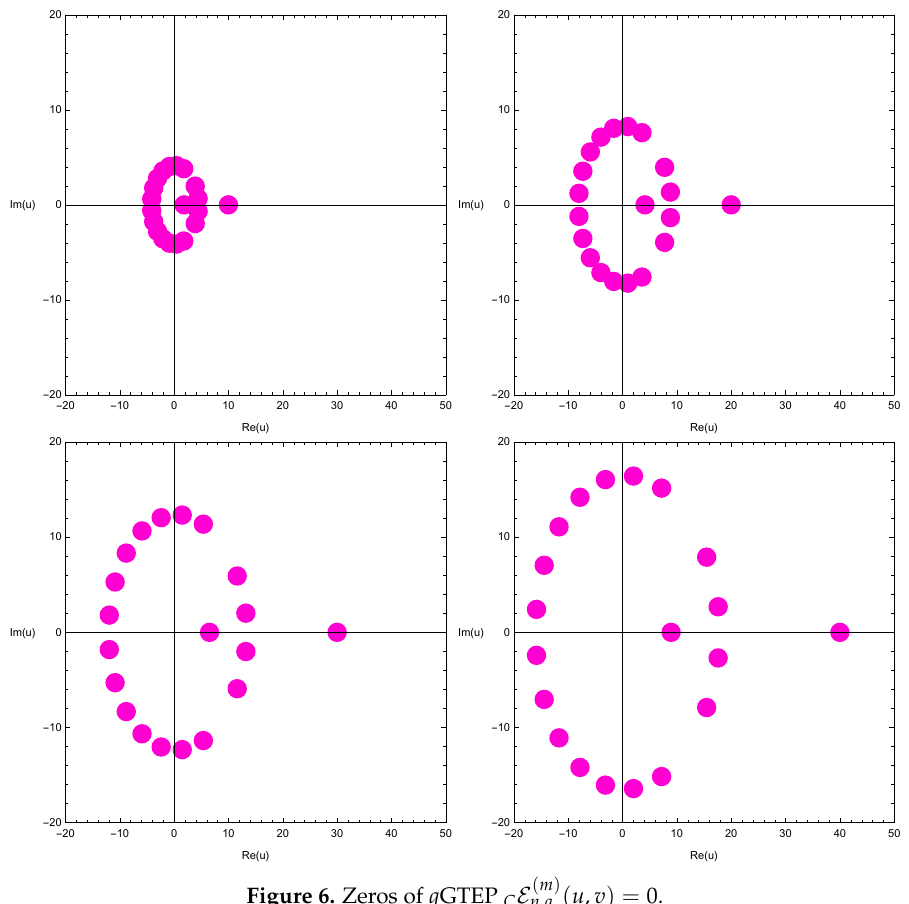
Figure 6. Zeros of q GTEP C E